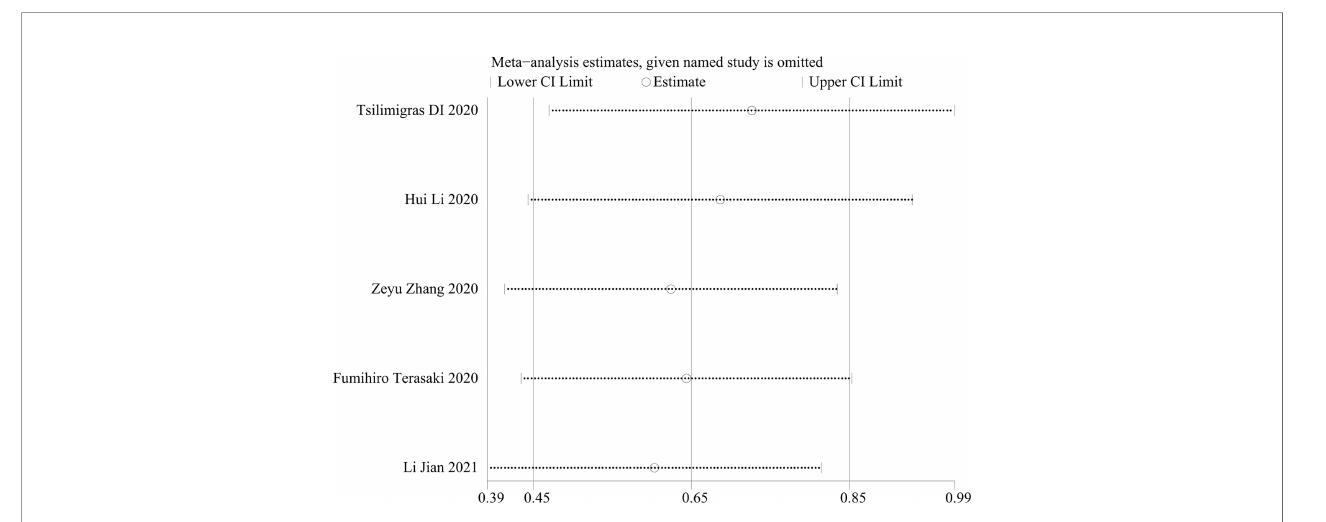
FIGURE 6 | Sensitivity analysis of the